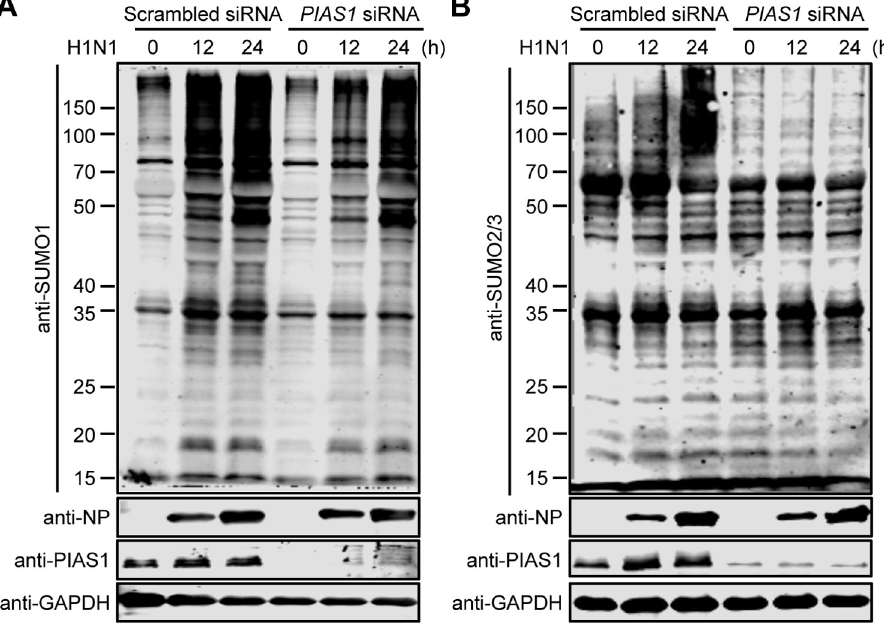
SUMOylation level was assessed at 0, 12, and 24 h p.i. by western blotting with an anti-SUMO1 (A) or anti-SUMO2/3 (B)